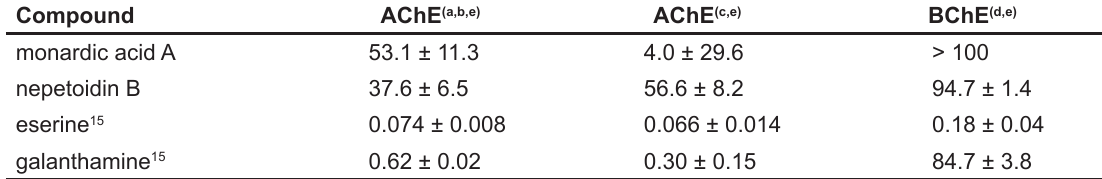
Table 1. Cholinesterase inhibitory activities of compounds from Thymus gobicus